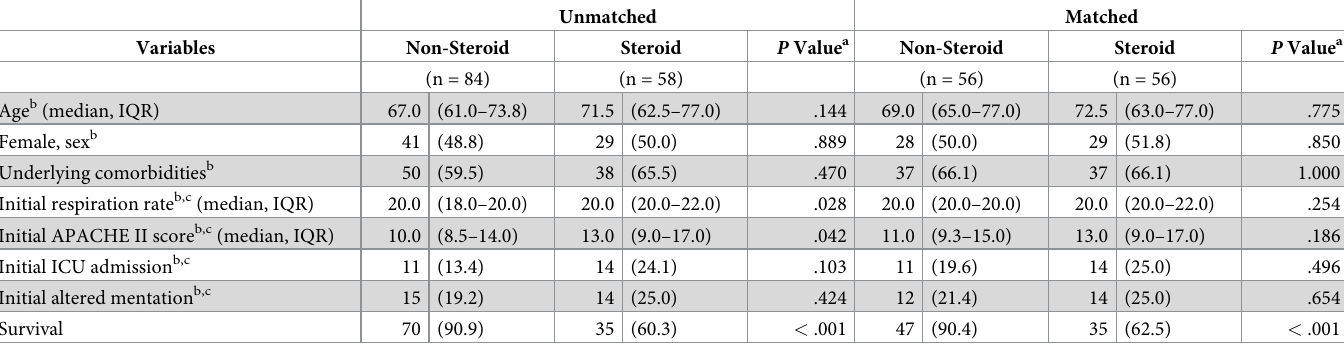
Table 6. Characteristics of the SFTS Cohort Before and After Propensity Score